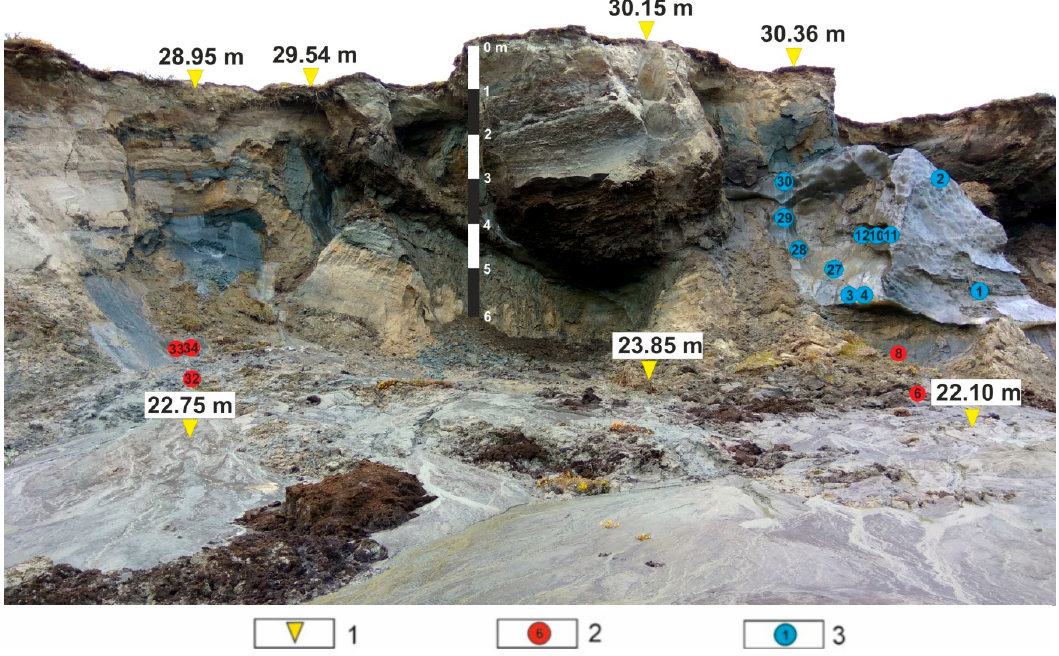
Figure 2. Location of sampling points in thermocirque at Vaskiny Dachi (photo by A.I. Kizyakov [24]). Legend: 1 —elevation (meters above sea level); 2 —location and number of tabular ground ice (TGI) sample; 3 —location and number of ice-wedge sample.